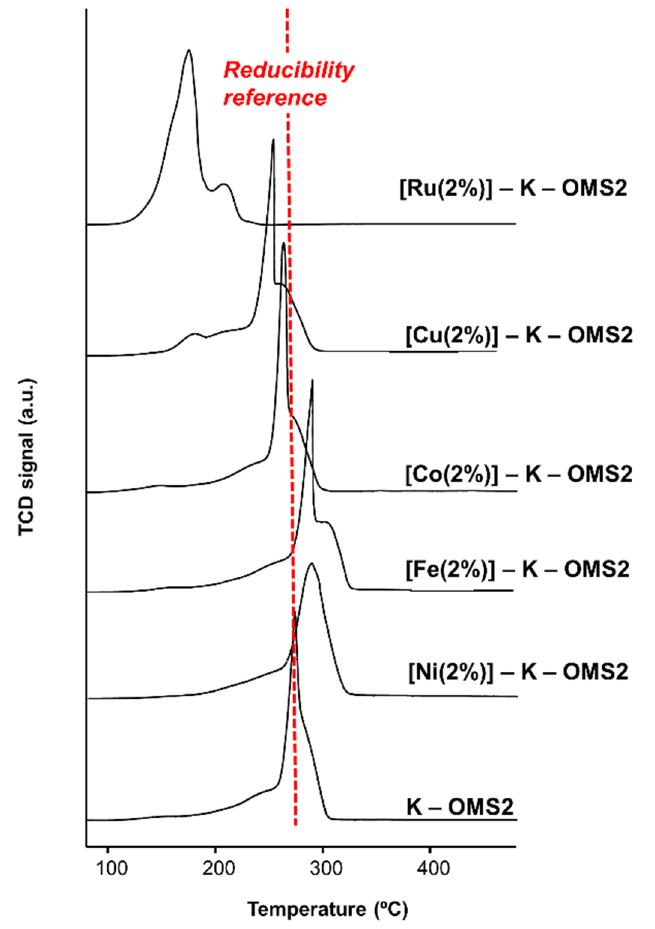
Figure 12. H 2 -TPR profiles for [M]–K–OMS–2 materials and undoped K–OMS–2. Extracted and adapted from [133].